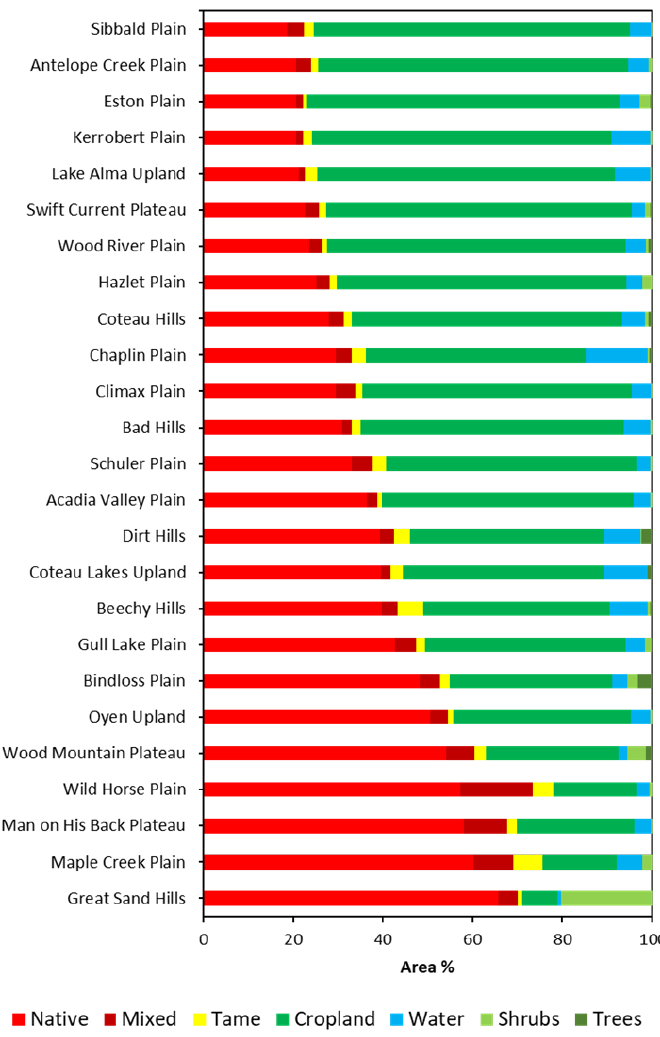
Figure 8. The shared area percentages (%) of PLI classes over the 25 landscape areas in the MGE of Saskatchewan.